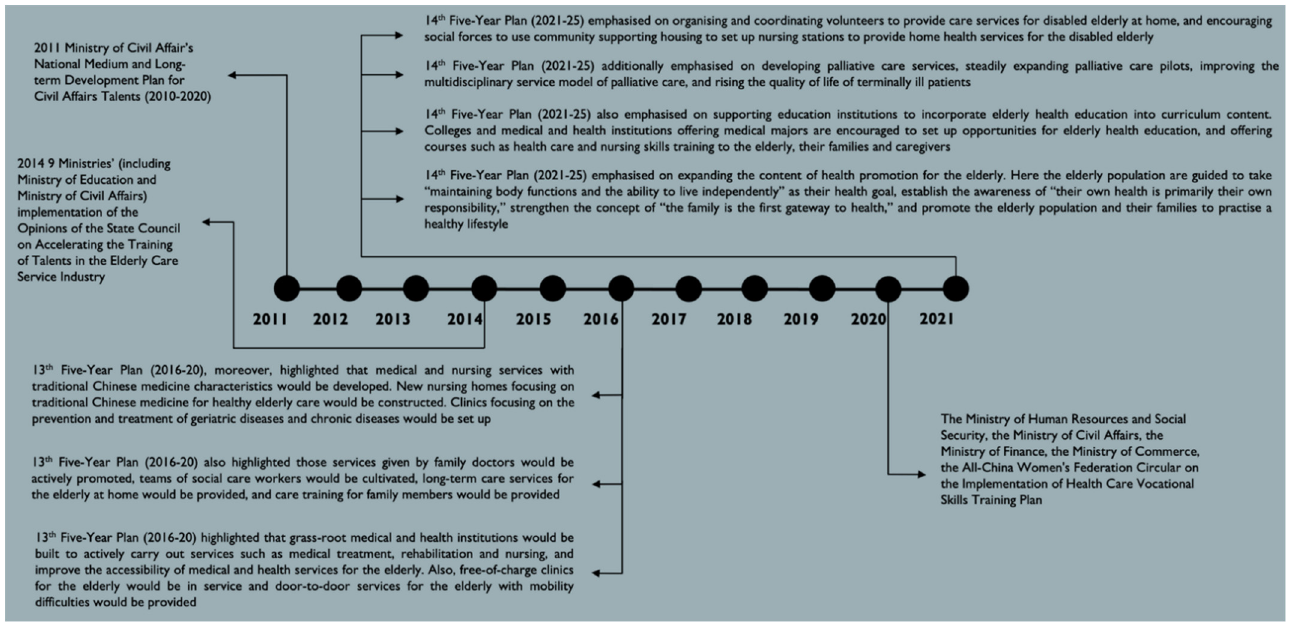
Figure 1. The Timeline of Older Population Care Policy Development on Human Resources Development in China.